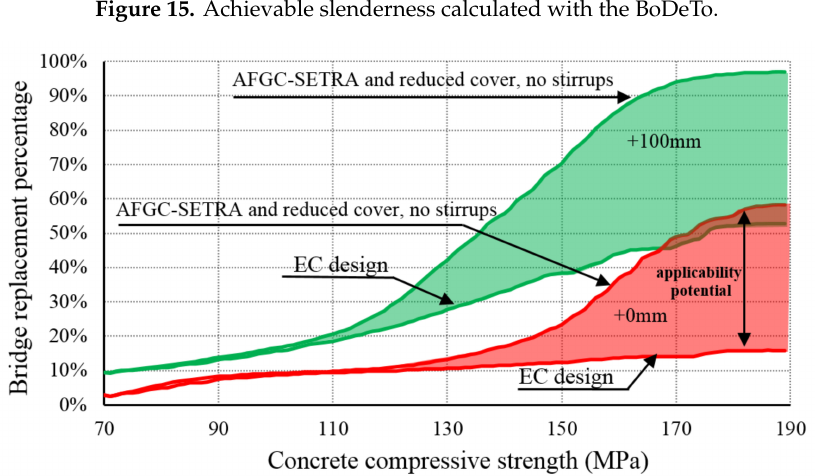
Figure 16. Percentage of three-span plate bridges in the Netherlands for which the SMART bridge replacement can be